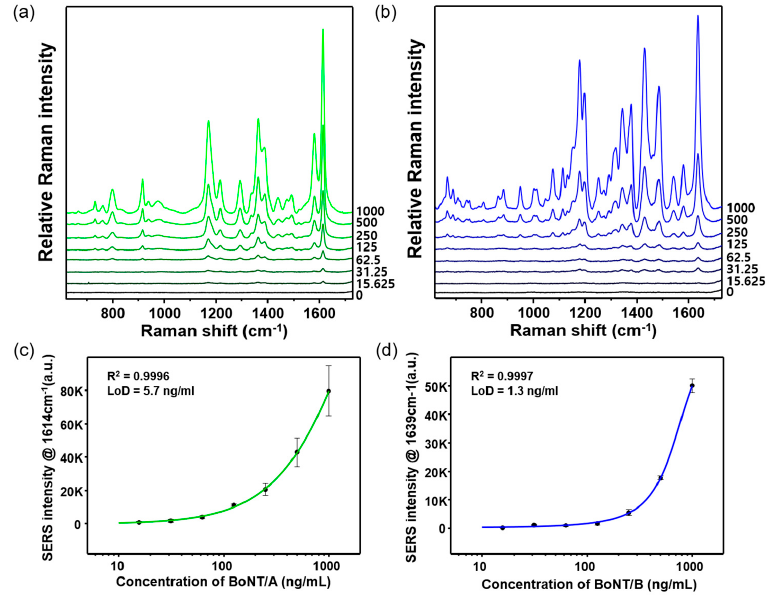
Figure 4. Raman spectra of various concentrations of ( a ) BoNT / A and ( b ) BoNT / B. Concentration range for BoNT / A and BoNT / B was 0 to 1000 ng / mL. Corresponding calibration curves for ( c ) BoNT / A and ( d ) BoNT / B toxins. The error bars indicate standard deviations from three measurements.